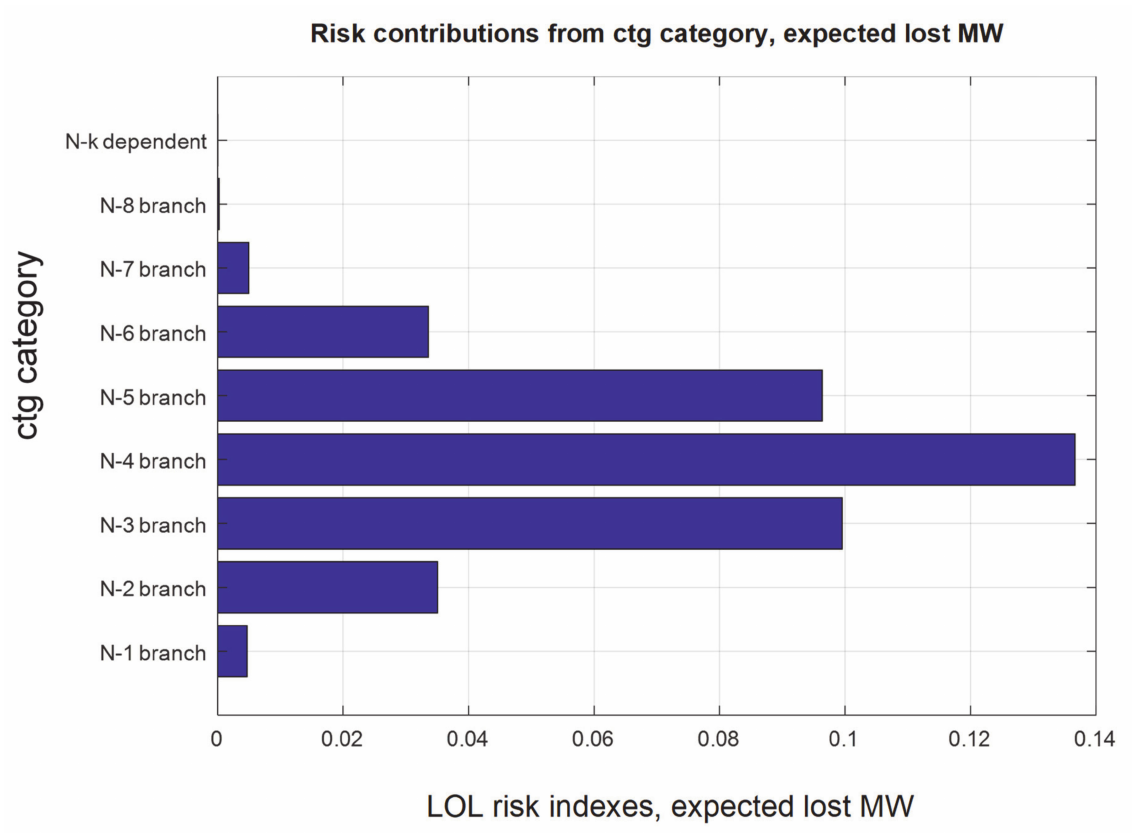
Figure 5. Contributions to the total LOL risk of each contingency category, case